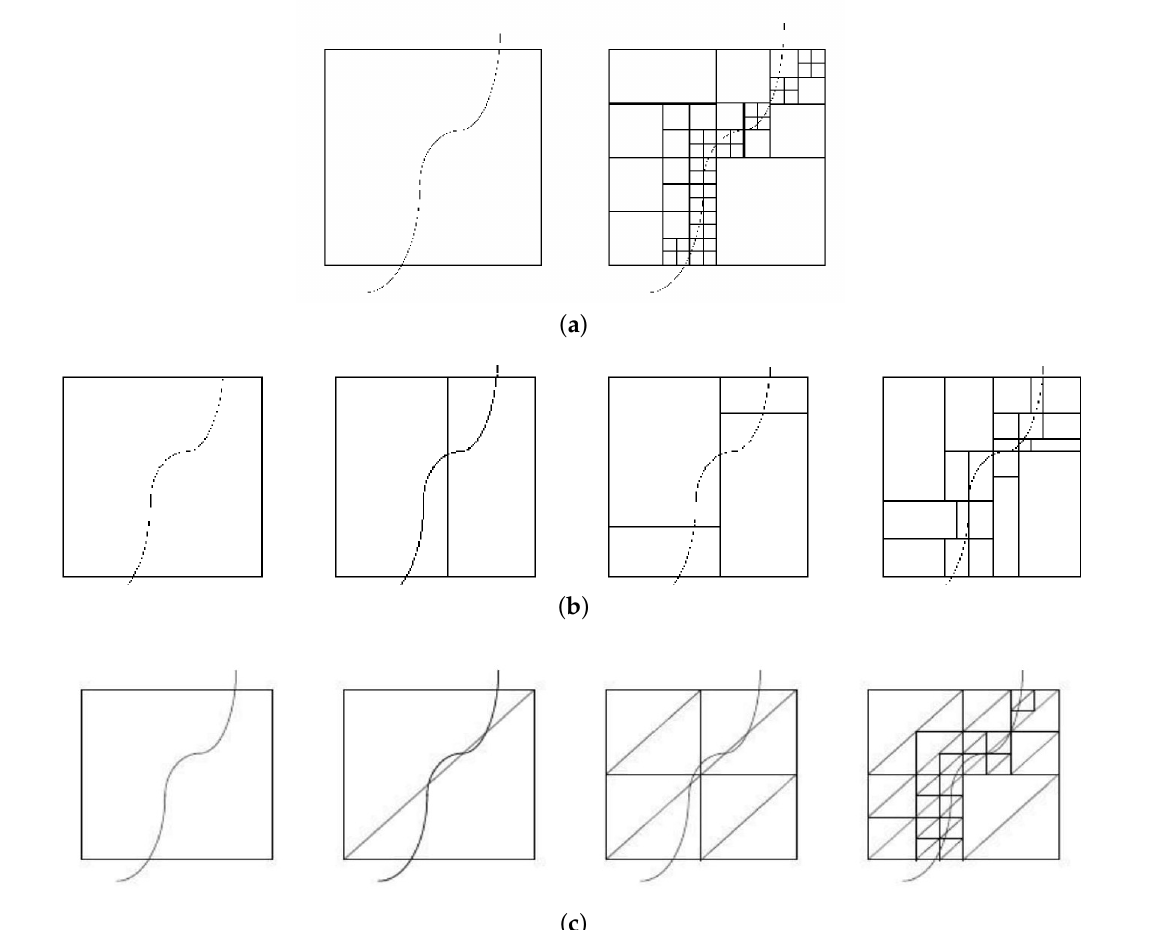
Figure 35. Some popular partitioning schemes, ( a ) Quadtree partitioning, ( b ) HV partitioning, ( c ) Triangular partitioning.